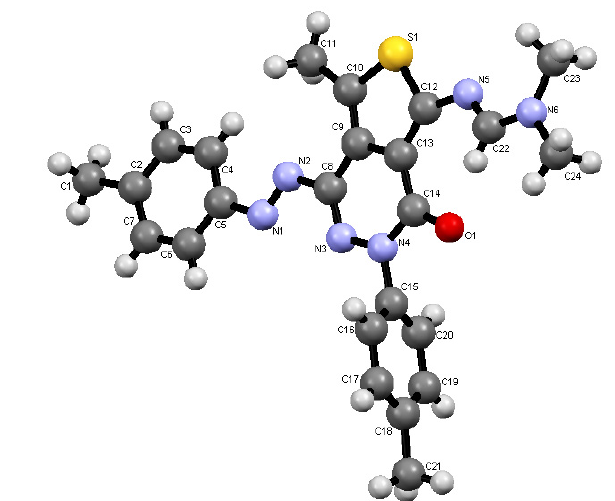
Figure 2. ORTEP plot of the X-ray crystallographic structure of 8